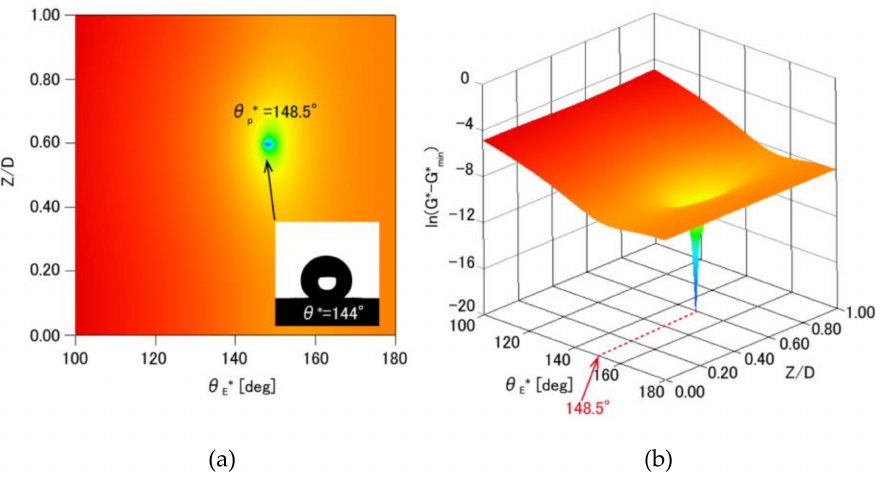
Figure 8. Contour maps (2D map:(a), 3D map:(b)) showing changes in the GFE density (In( G * − G * min )) as a function of the estimated apparent contact angle ( θ ∗ ) with the normalized position at the water-air E interface ( Z / D ) in an inverted moth-eye structure made of PDMS ( θ = 100 ◦ ). The insert in the 2D map is a captured image of a water droplet on the inverted moth-eye structure. The blue region represents the global minimum in the GFE